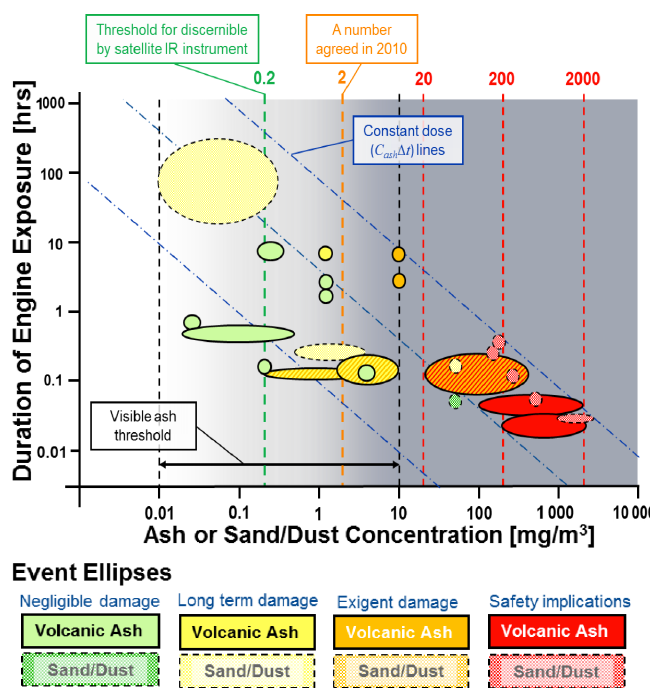
Figure 1. The duration of exposure versus ash concentration chart, populated with known aircraft encounters with dust clouds and results from the rig test, as taken from